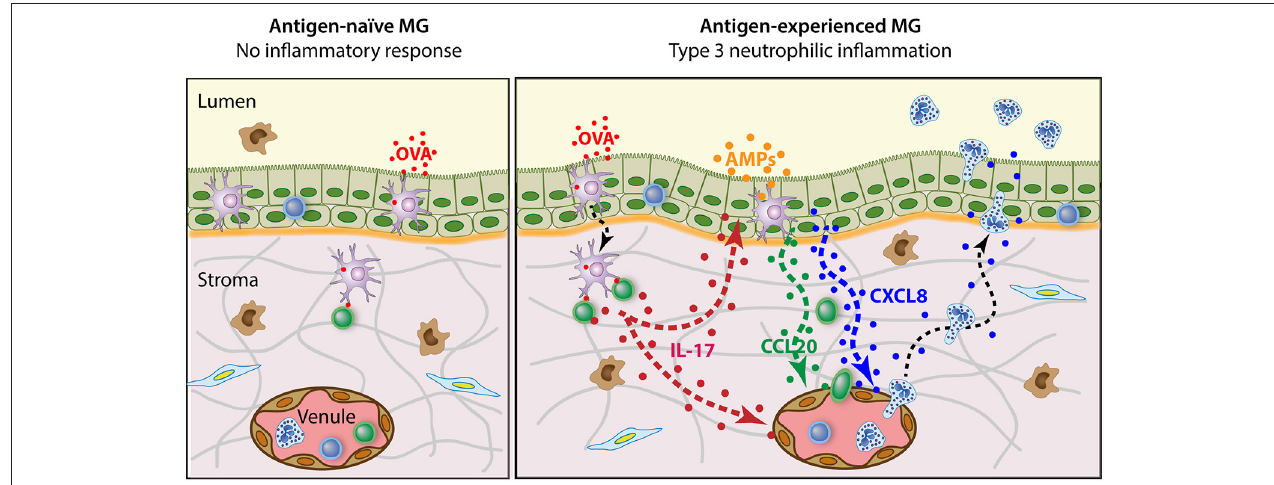
FIGURE 2 | Schematic representation of the antigen-specific mammary inflammatory response. The antigen-naïve MG does not react to the intraluminal infusion of pyrogen-free antigen such as purified ovalbumin (OVA). By contrast, when OVA is infused in the lumen of antigen-experienced MGs, an intense neutrophilic inflammation develops. This reaction depends on the presence of Th17 cells in the mammary tissue and involves the local production of IL-17A and IL-17F. In turn, mammary epithelial and endothelial cells secrete chemokines such as CXCL8 and CCL20 that attract neutrophils and lymphocytes, and express adhesion molecules that facilitate diapedesis and transepithelial migration. Additionally, IL-17 in conjunction with pro-inflammatory cytokines induces mammary epithelial cells to produce antimicrobial peptides